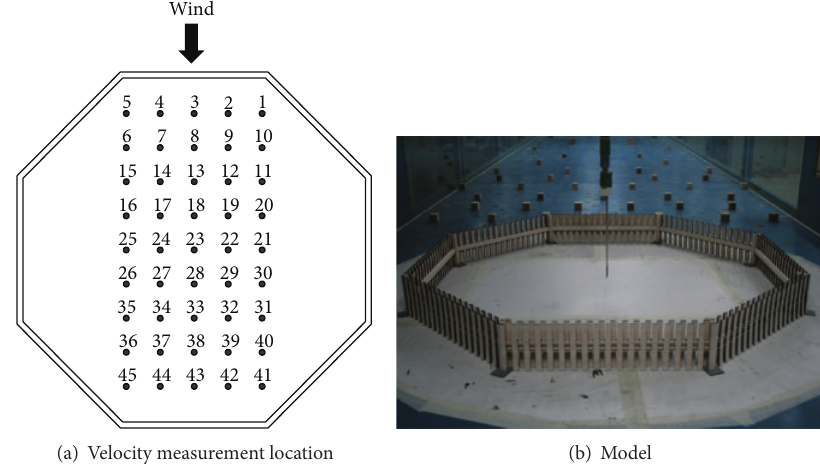
Figure 16: Wind velocity measurement locations and CASE 2 model installed in the wind tunnel.